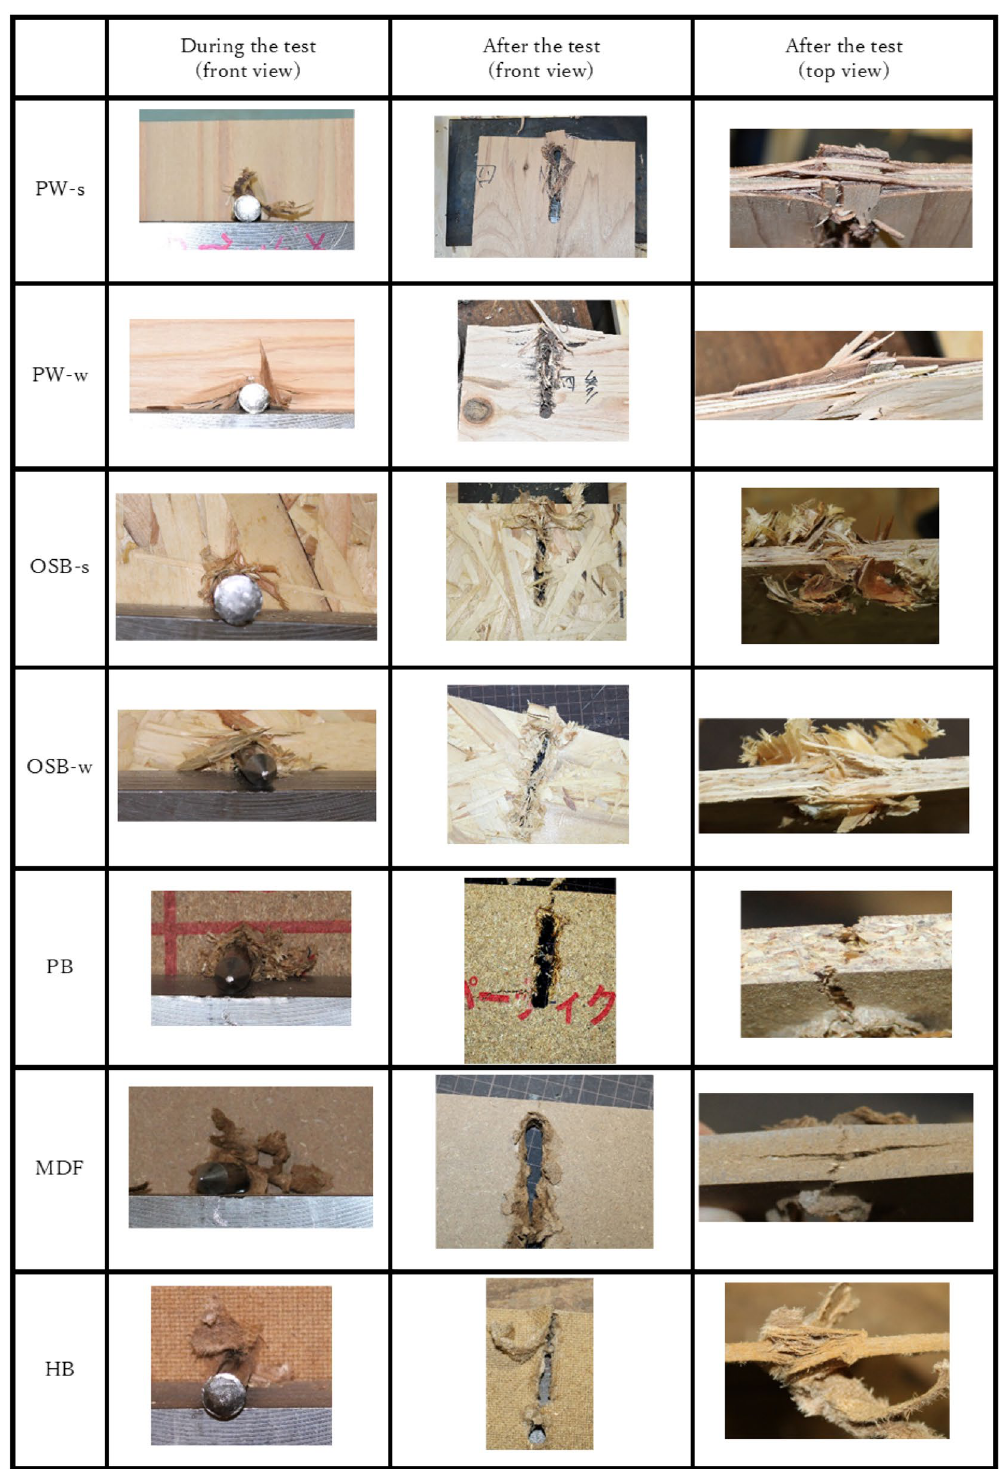
Fig. 7 Comparison of ESF behavior among panel